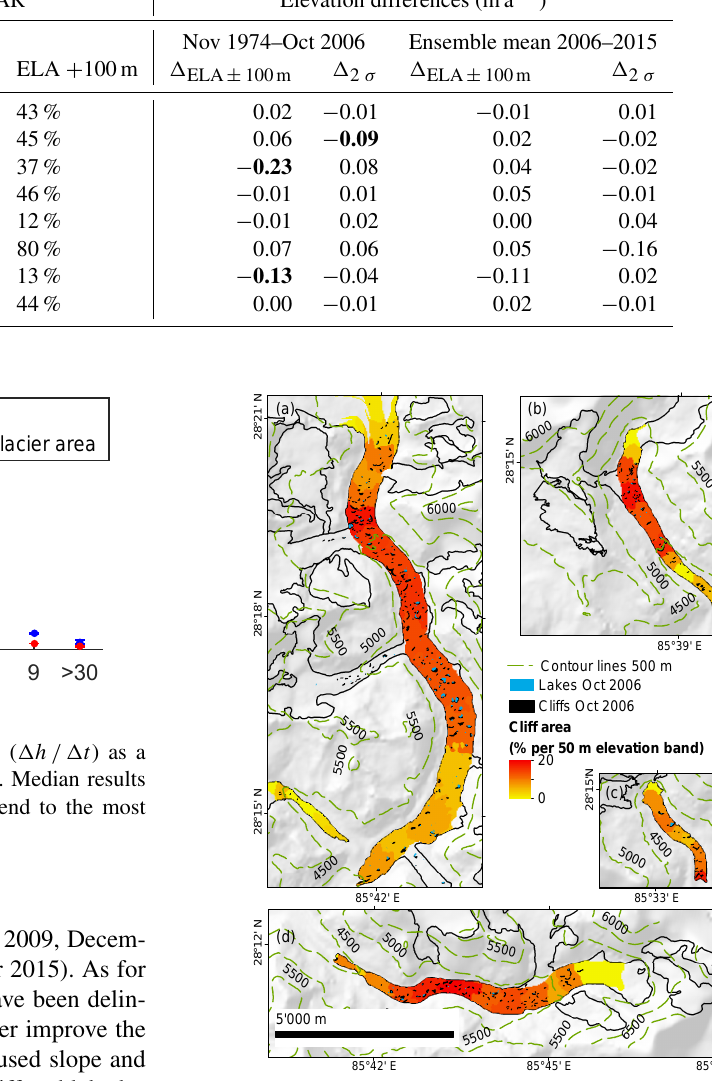
Figure 6. Supraglacial cliffs and lakes as identified from the Oc- tober 2006 Cartosat-1 satellite image: (a) Langtang and Ghanna glaciers, (b) Shalbachum Glacier, (c) Lirung Glacier and (d) Lang- shisha Glacier. Cliff area shows the median fraction (%) of 30m pixels per 50m elevation band that contain cliffs, considering all six available cliff maps from 2006 to